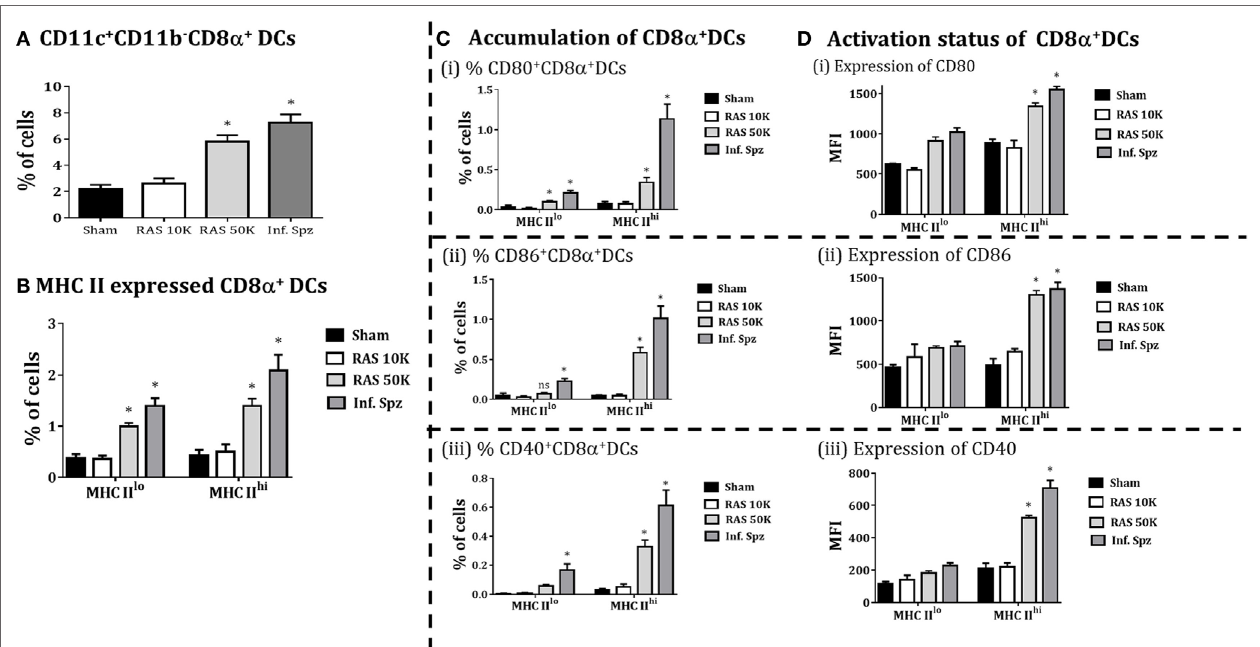
FigUre 5 | CD8 α + dendritic cells (DCs) in response to differential dose of radiation-attenuated sporozoites (RAS) (10K or 50K). (a) Accumulation of CD8 α + DCs is significantly increases with dose 50K RAS as compared to 10 K RAS as shown in the figure, (B) CD8 α + DCs subdivided in MHC-II high (MHCII hi ) and MHC-II low (MHCII lo ) DCs, (c) accumulation of CD8 α + DCs with expression of CD80, CD86, and CD40, (D) activation status of CD8 α + DCs with the expression of MHCII (high or low), shown expression of CD80 and CD86 measured as the mean fluorescent intensity (MFI) in CD8 α + DCs in the liver. Percent cell shown is the percent out of total mononuclear cells. N = 4 mice per group. Data are the mean ± SEM. The data were analyzed with non-parametric Mann–Whitney U -test. p < 0.05 is considered as a significant. Data shown represent one of two independent